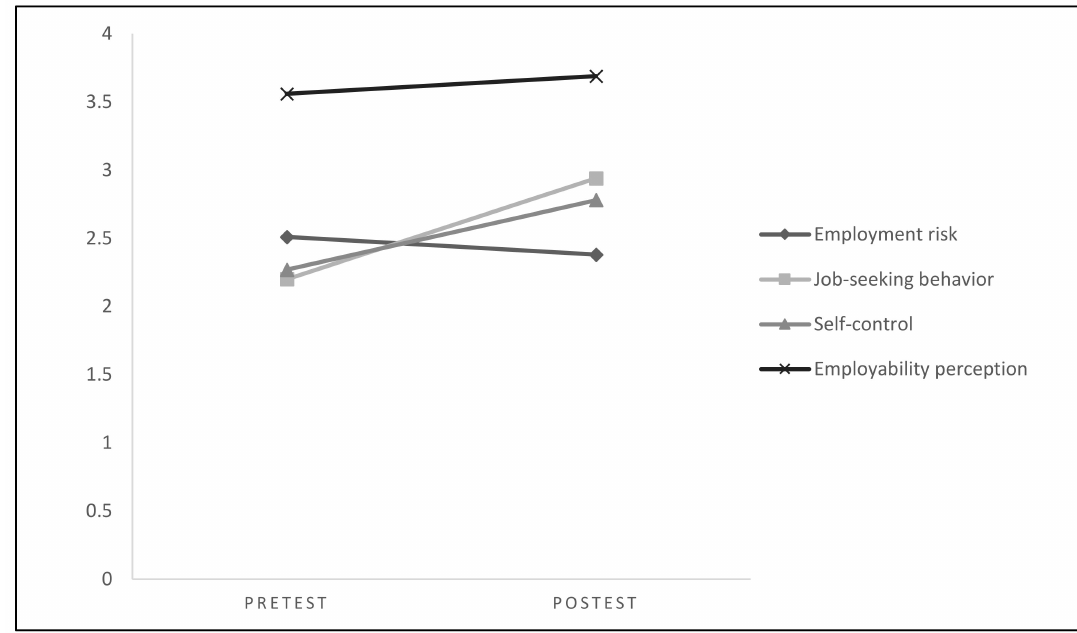
Figure 1. Pretest and post-test direct